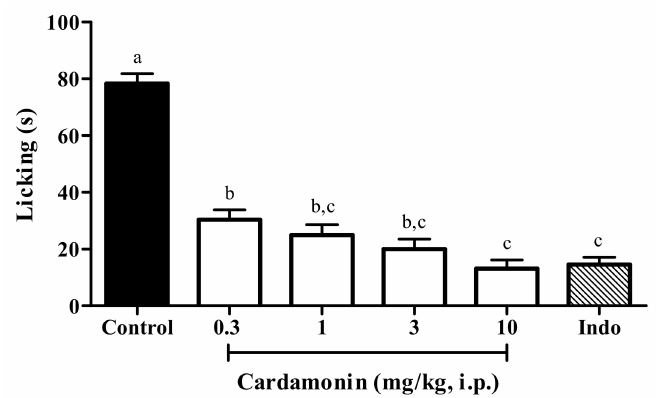
Figure 2. E ff ect of cardamonin (0.3, 1, 3 and 10 mg / kg; i.p.) against phorbol 12-myristate 13-acetate (PMA)-induced nociception. Each column represents the mean ± S.E.M. of 6 mice. Control